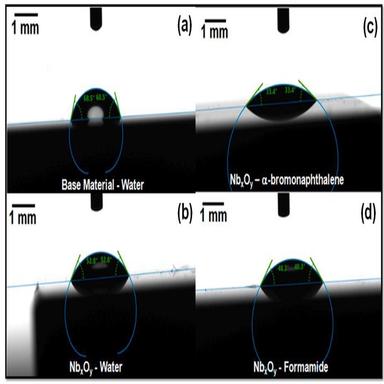
Results of wettability measurements (a) Base material in water, (b) Nb2O5 in water, (c) Nb2O5 in α-bromonapththalene and (d) Nb2O5 in Formamide.